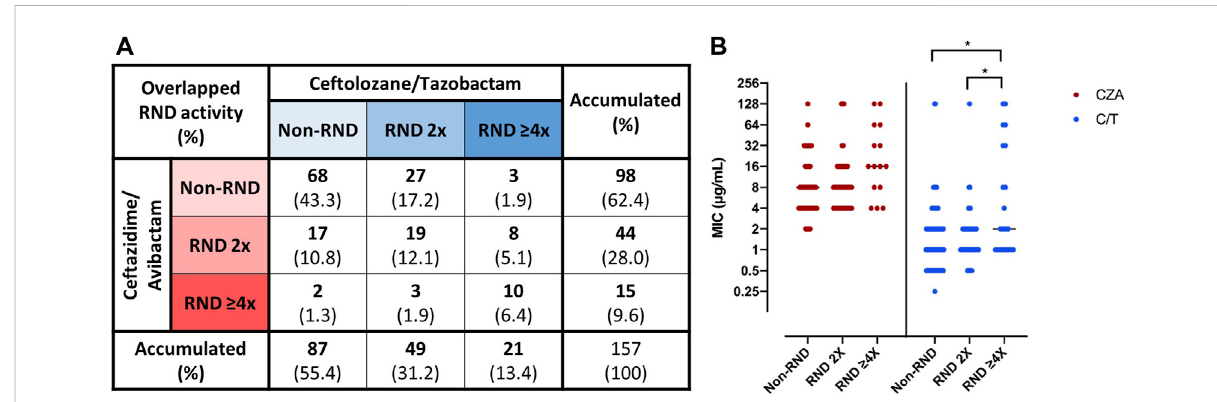
FIGURE 3 RoleofRNDef fl uxsystemson “ baselinesusceptibility ” toCZAandC/TinNon-CP-CRPAclinicalisolates.Non-CP-CRPAisolateswereclassi fi ed as “ Non-RND ” , “ RND 2x ” , and “ RND ≥ 4x ” according to the increase in the levels of CZA or C/T susceptibility in the presence of the ef fl ux pump inhibitor,PA β N.TheisolateswithequalorhigherMICvaluesinthepresenceofPA β Nwerenamed “ Non-RND ” ,andnocontribution oftheRNDef fl ux systemsinCZAorC/Tsusceptibility wasconsidered.TheisolateswhoseMIC valuesdecreasedtwo-foldormorethan two-foldinthepresence ofPA β Nwerenamed “ RND2x ” or “ RND ≥ 4x ” ,respectively, andaroleoftheRNDef fl uxsystemsinCZAorC/Tsusceptibility wasconsidered.Panel (A) shows the proportion of the Non-CP-CRPA isolates with the different combinations of overlapped RND contribution to CZA and/or C/T susceptibility.Panel (B) showstheCZAandC/TMICdistributionamongtheindividualisolatesclassi fi edas “ Non-RND ” , “ RND2x ” ,and “ RND ≥ 4x ” .The results showed that (A) 37.6% ( n = 59), 44.6% ( n = 70), and 25.5% ( n = 40) of Non-CP-CRPA analyzed ( n = 157) were considered as “ RND ” (sum of “ RND 2x ” and “ RND ≥ 4x ” )for CZA, C/T, or both, respectively. The CZA and C/T MIC distribution among “ Non-RND ” , “ RND 2x ” and “ RND ≥ 4x ” isolates showed a signi fi cant increase of C/T MIC values in “ RND ≥ 4x ” , evidencing that RND may contribute to a high level of C/T